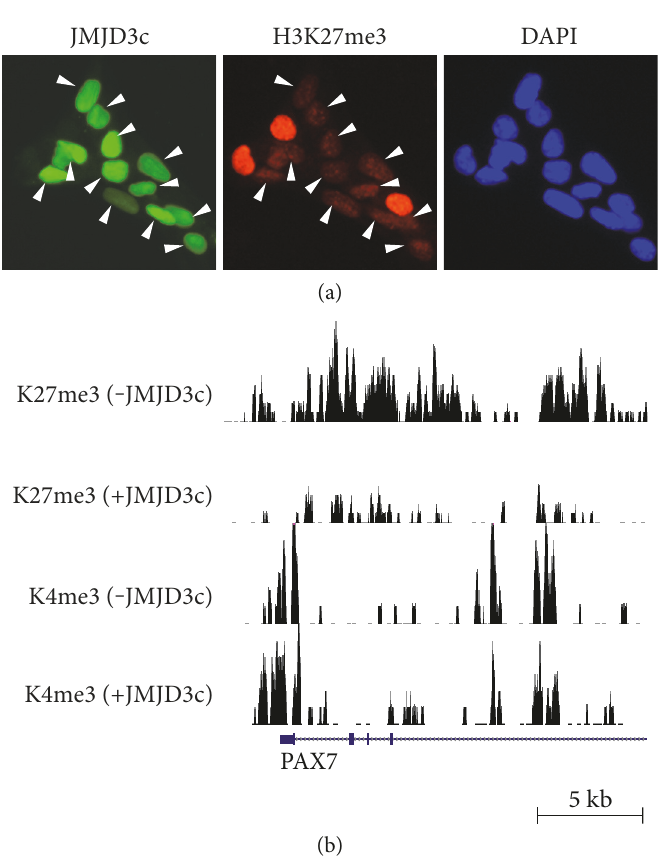
Figure 3: H3K27me3 demethylation in hESCs by forced expression of JMJD3c. (a) Immunostaining analysis showing the H3K27me3 demethylation in whole nuclei of hESCs by JMJD3c overexpression (arrows). (b) ChIP-sequencing analysis showing the signi fi cant reduction of H3K27me3 at the PAX7 gene in hESCs by JMJD3c overexpression. H3K4me3 enrichment remains at the PAX7 gene after JMJD3c